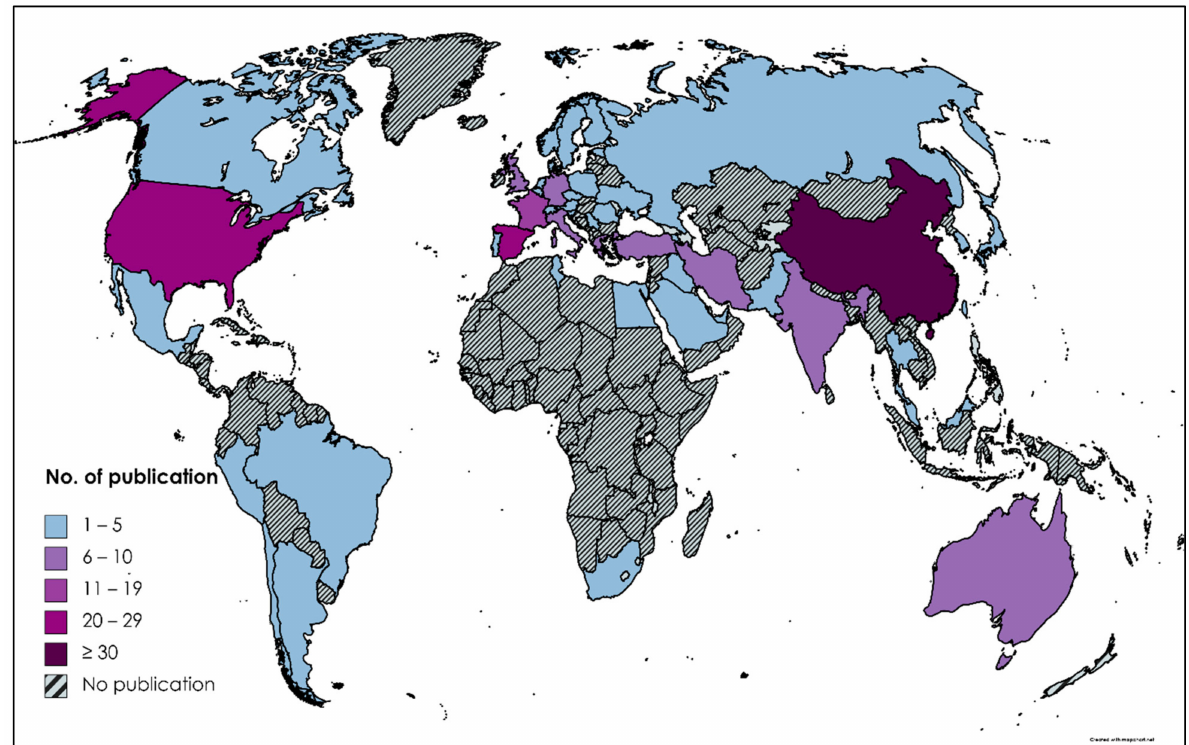
Figure 4. Global representation of the number of the publication. The map was created with mapchart (https://mapchart. net/) accessed date 13 August